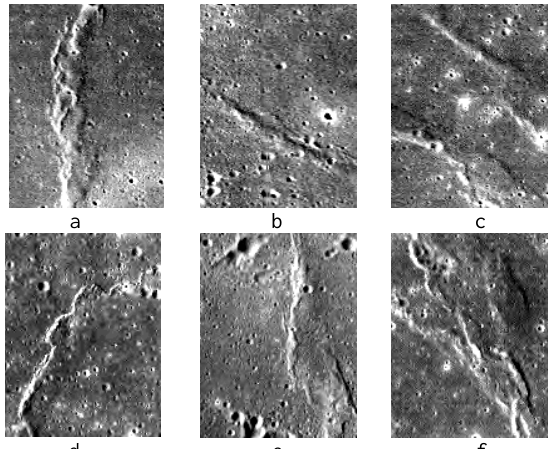
Figure 2. The WAC images of lunar ridges at test